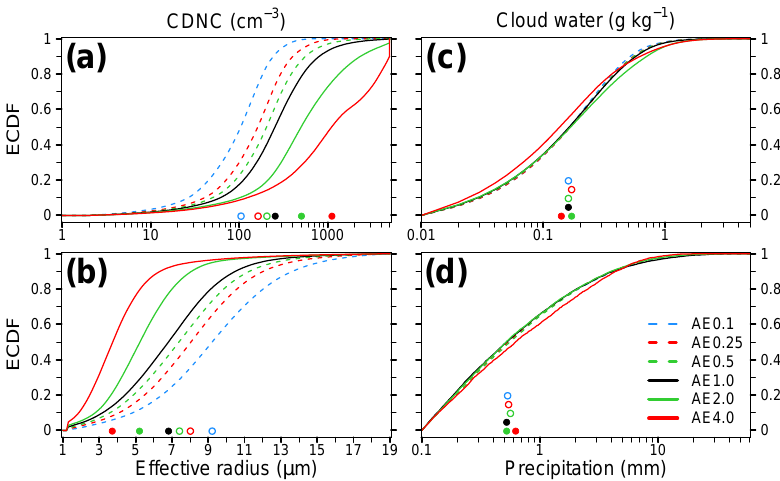
Figure 14. Empirical cumulative distribution function (ECDF) of (a) CDNC (cm − 3 ), (b) cloud droplet effective radius (µm), (c) cloud water (gkg − 1 ) and (d) precipitation (mm) for the six experiments in Table 1 considering the full vertical column over the inland area of SWA on 2 July 15:00UTC. The circles and dots highlight the median values. Dashed lines and circles relate to realizations with less aerosol than the reference case and solid lines and dots refer to simulations with aerosol amounts greater than or equal to the reference case.